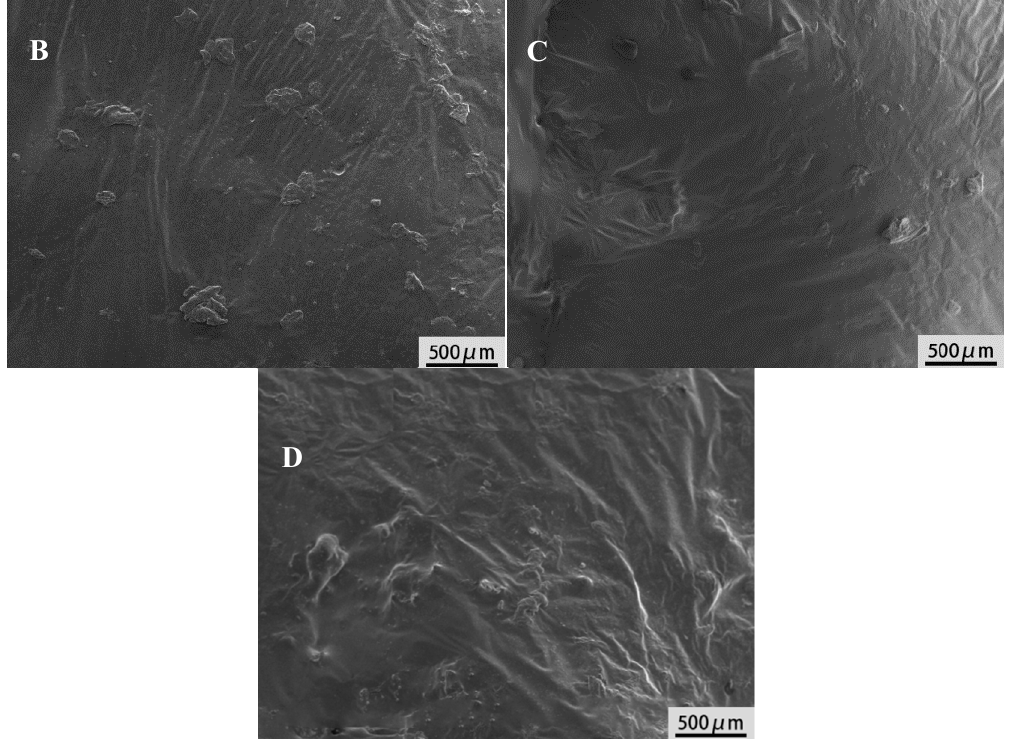
Figure 5. SEM images of modified asphalt binders. B—modified asphalt binder with unactivated rubber, C—modified asphalt binder with coating-activated rubber and D—modified asphalt binder with grafting-activated rubber.